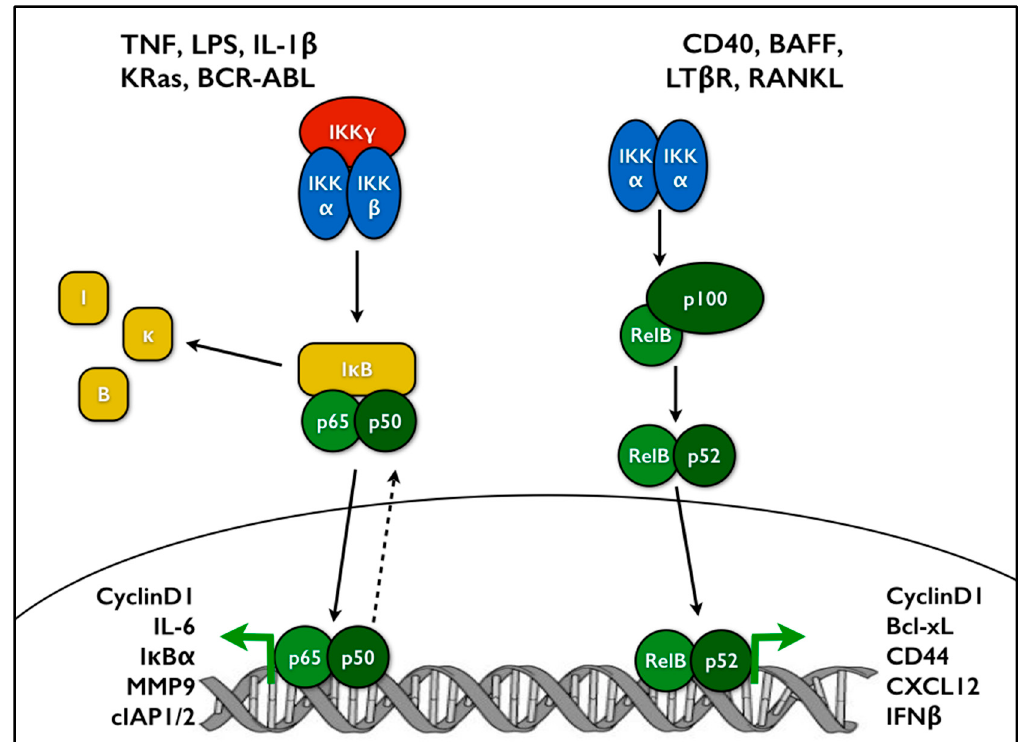
Figure 1. NF- κ B signaling consists of two main branches: canonical and non-canonical. On the left, canonical NF- κ B is driven by the IKK complex containing IKK α , β , and γ subunits. Phosphorylation of I κ B α leads to its degradation, allowing the p65-p50 dimer to accumulate in the nucleus and regulate transcription of target genes. On the right, non-canonical NF- κ B is driven by IKK α homodimers, leading to p100 processing. Here the dimer consists of the RelB and p52 subunits. Canonical and non-canonical NF- κ B subunits regulate expression of distinct and overlapping sets of target genes [7].